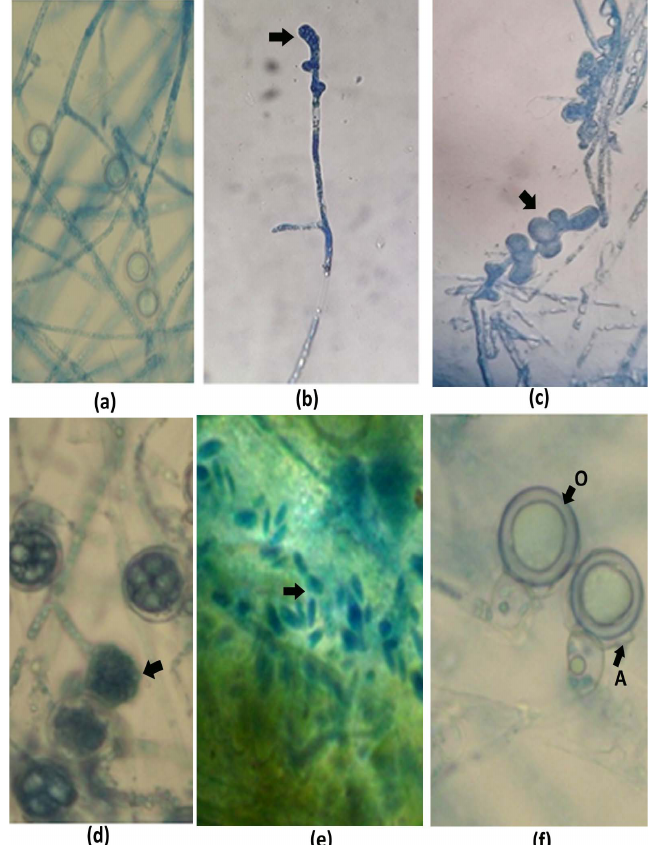
Figure 5: Microscopic images (10 x 40) of vegetative and reproductive structures of isolates. (a) Hyaline, aseptate, dichotomously branched hyphae, (b) The mycelium with swollen tips, (c) Lobose sporangium, (d) Zoospores within sporangium, (e) Zoospores in induction solution, (f) Oogonium and